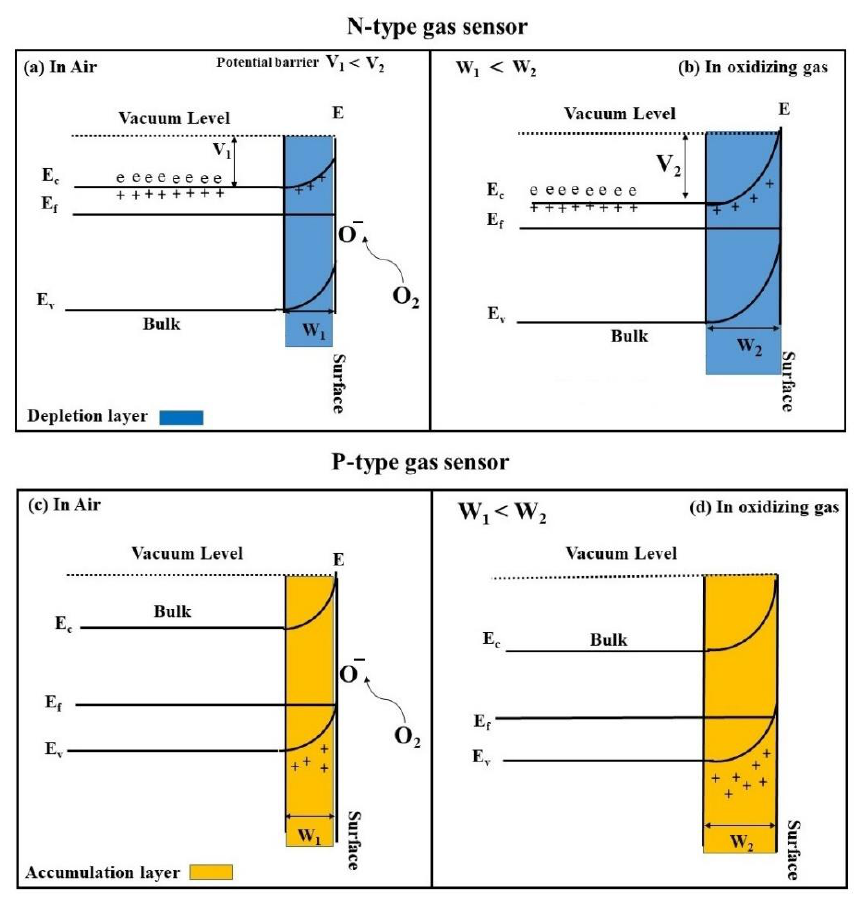
Figure 3. The general gas-sensing mechanism of ( a , b ) n-type and ( c , d ) p-type MOS gas sensors in the presence of air and an oxidizing gas.